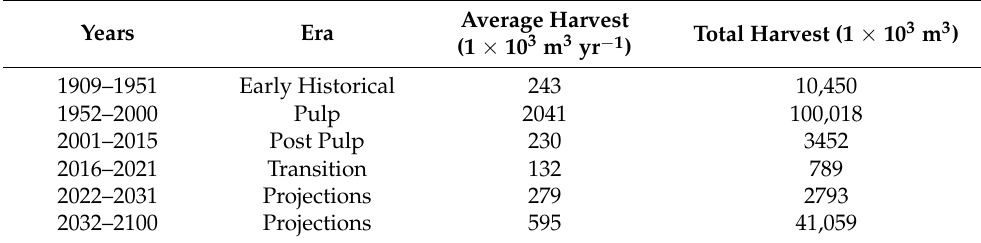
Table 1. Past (1909–2021) and projected (2022–2100) timber harvest levels on the Tongass National Forest by era, including average (thousand cubic meters per year) and total (thousand cubic meters) harvest levels. Projections are based on [10]. See Table S2 for annual harvest